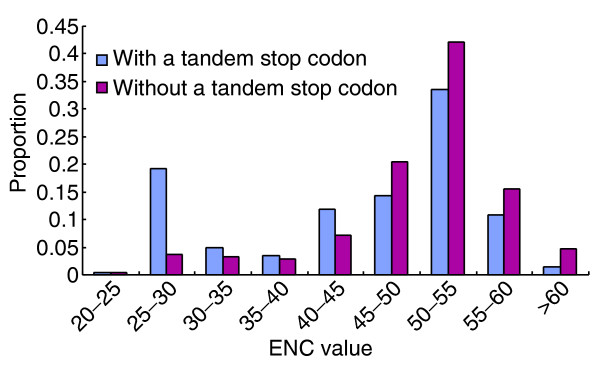
Distribution of tandem stop codons in different codon bias groups in S. cerevisiae. The blue bars represent the proportion of genes with a tandem stop codon; the red bars represent the proportion of genes without a tandem stop codon.